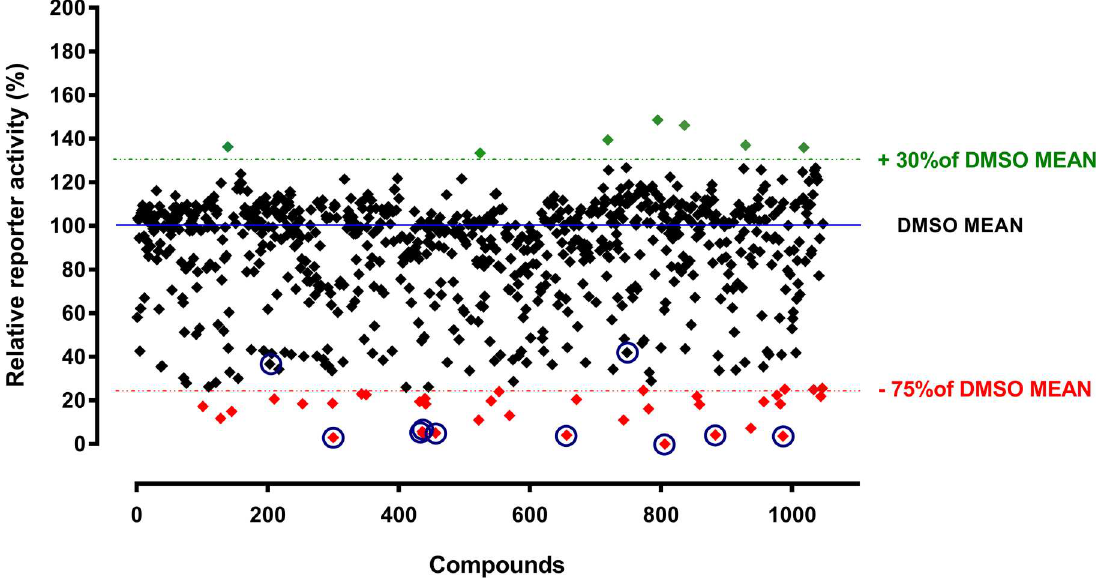
Fig 3. High-content screening of 1,200 Prestwick Chemical Library compounds. HeLa cells stably expressing firefly luciferase under control of NDST1 promoter were treated with compoundsfrom the Prestwick Chemical Library. The reporter activity of the tested compounds is expressed relative to the mean activity of DMSO treated cells. Drugs showingcytotoxic effects, as tested in parallelby the Hexosaminidase assay, were removed from the graph. Thirty eight compoundsresulting in the luminescence decrease by > 75% relative to the mean of DMSO control were consideredas potentially strong NDST1 inhibitors(shown in red). Seven compounds(shown in green) increasedluminescence by (cid:21) 30% over the mean DMS control. These compounds could be consideredas potential inducers of NDST1 expression. Eight potentiallystrong inhibitorsand 2 averageinhibitors(indicatedby blue circles) were selected for the dose-response assessment (Fig 4A). Experiments were performed in triplicates. Abbreviation: stdev–standard deviation.